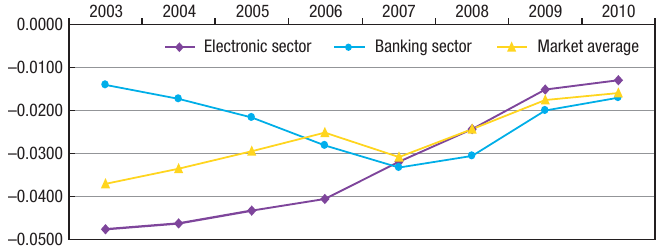
Fig. 5.  CoVaR i of electronic sector, banking sector and market average during 2003 to